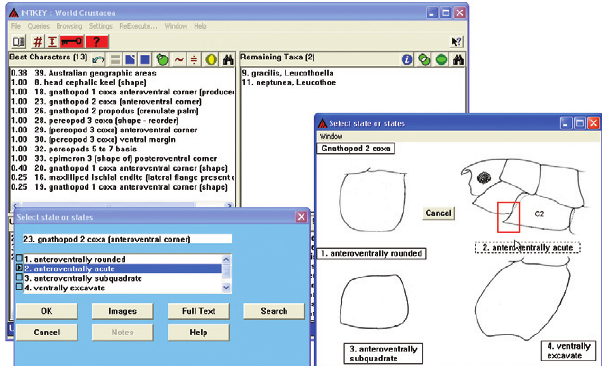
Figure 73. Clicking on the Images button during the selection of character states will show the illustra- tions for all character states.